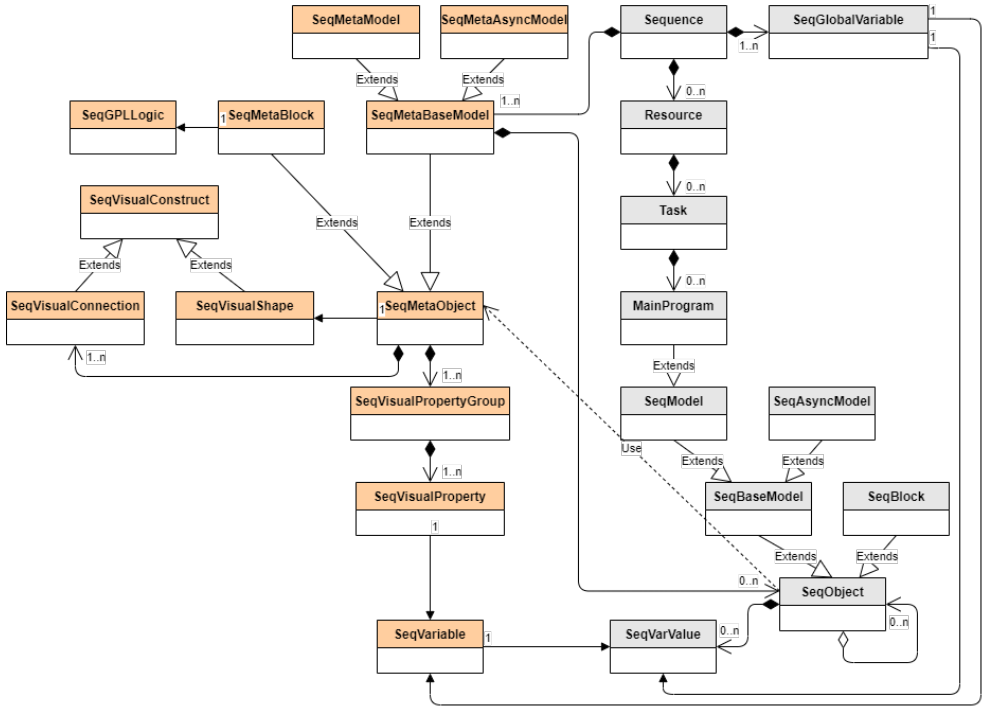
Figure 6. Metamodel class diagram of the